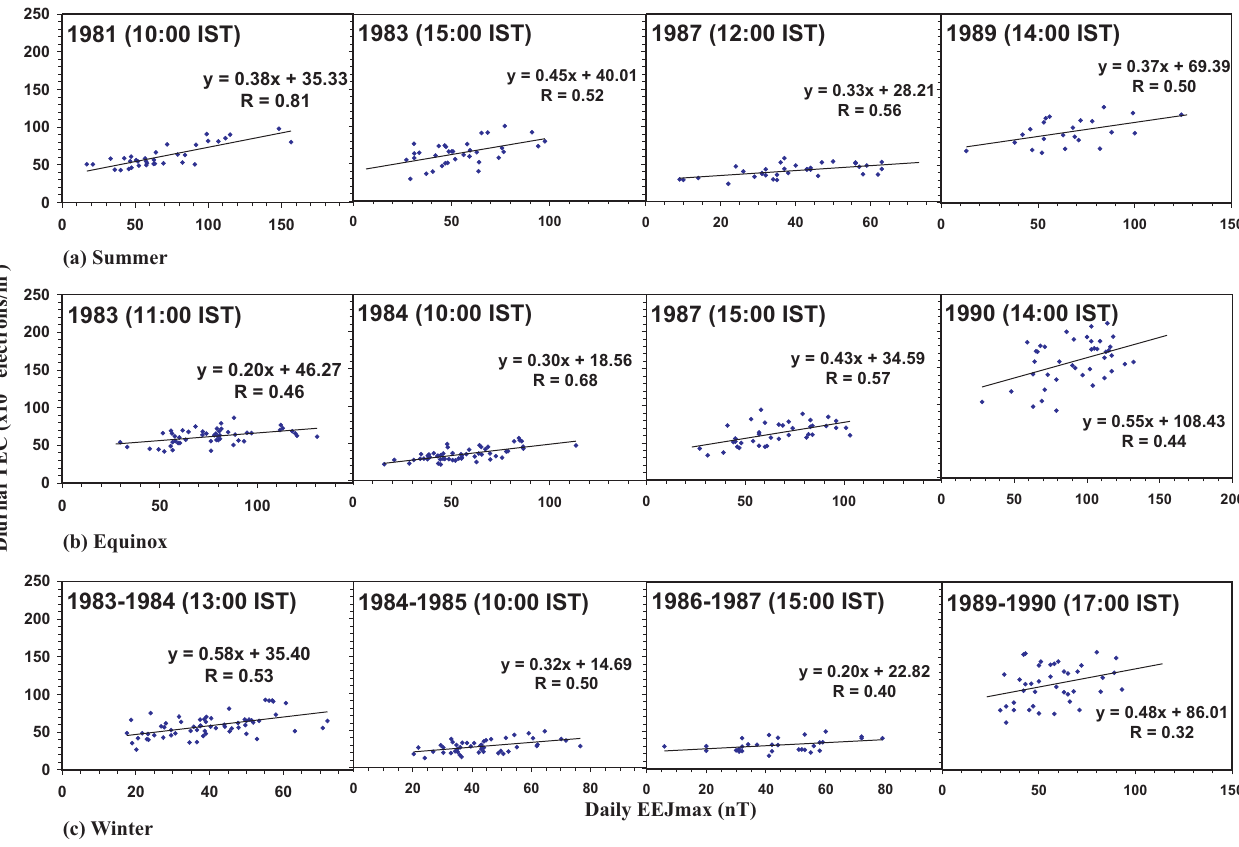
Fig. 3. Daily TEC at the indicated time and year vs. day’s maximum values of EEJ strength (nT). Plots are shown for the time of maximum correlation. Panel (a) corresponds to summer solstitial months, (b) pertains to equinoctial period and (c) refers to winter season.